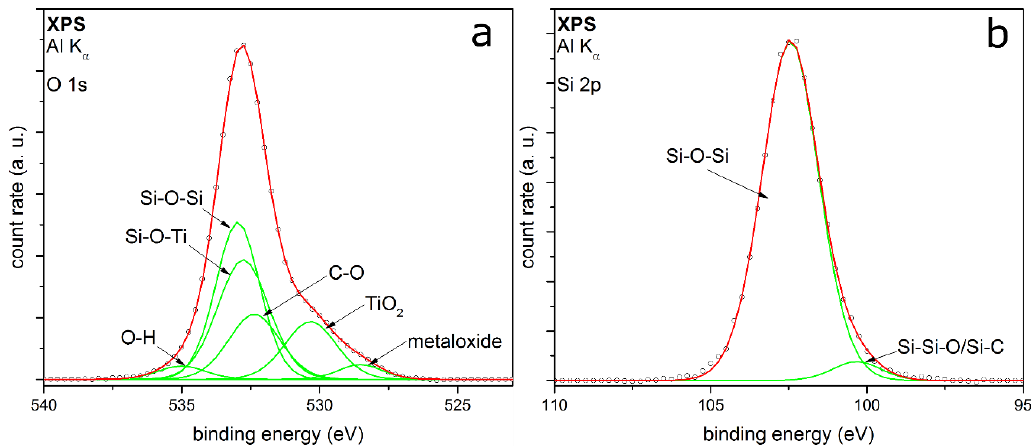
Figure 5. XPS detail spectra of ( a ) O 1s and ( b ) Si 2p of titania particles coated with TEOS as precursor.